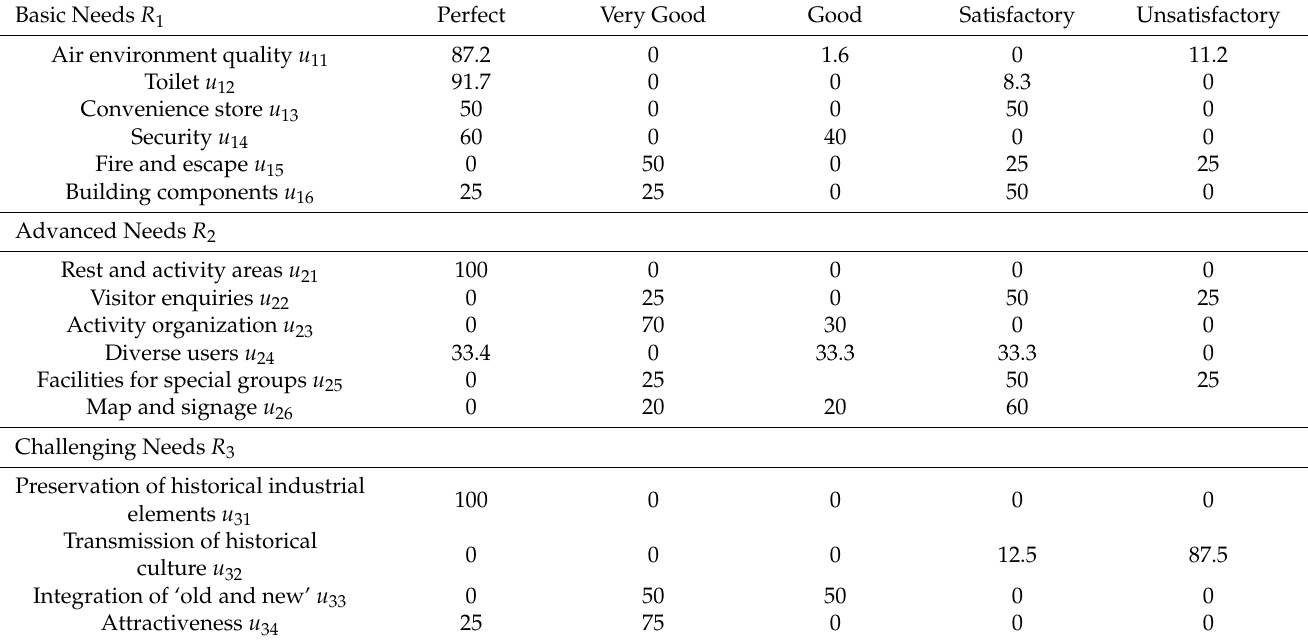
Table 3. The scored measuring framework (by author,